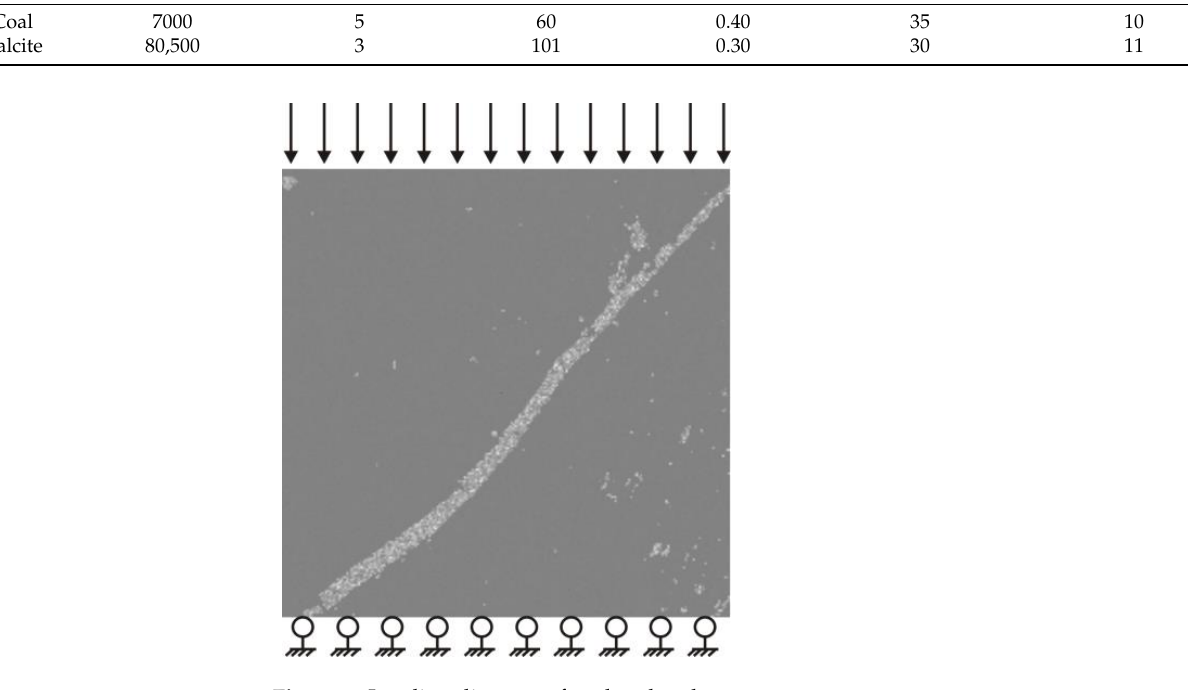
Table 2. Modulus of elasticity and uniaxial compressive strength of coal rock. Azimuth/(°)